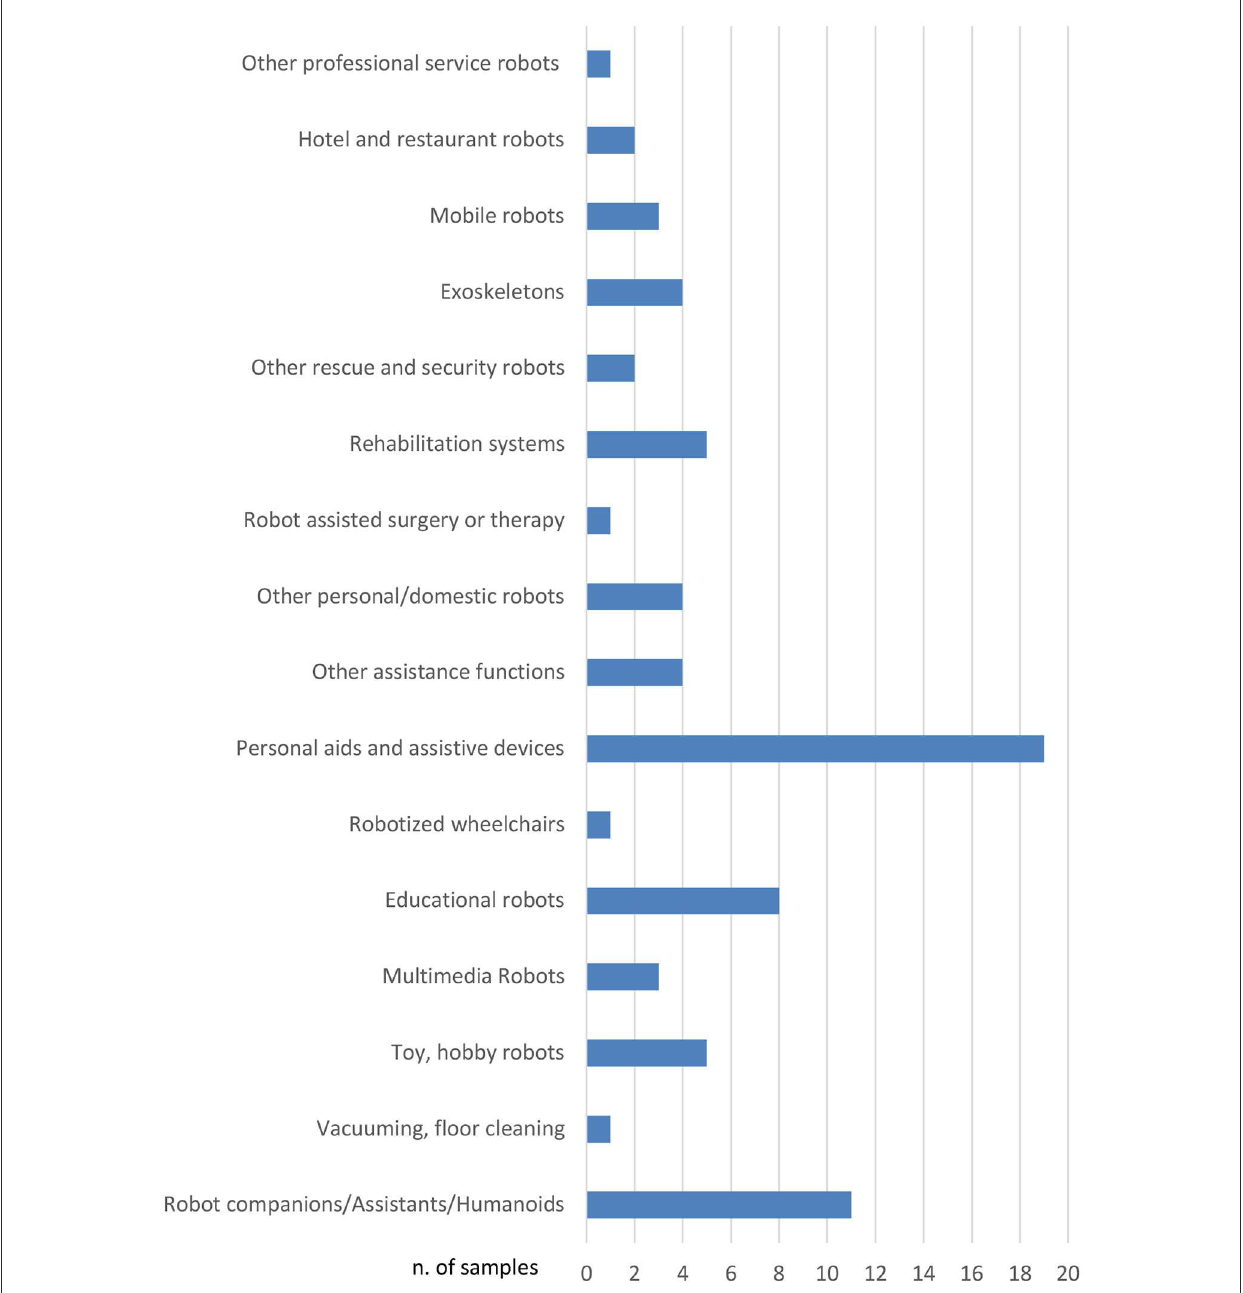
FIGURE3 Type of robots distribution for the 75 robots collected in the analysis, according to the classification proposed in Turja et al. (15) and summarized in Table